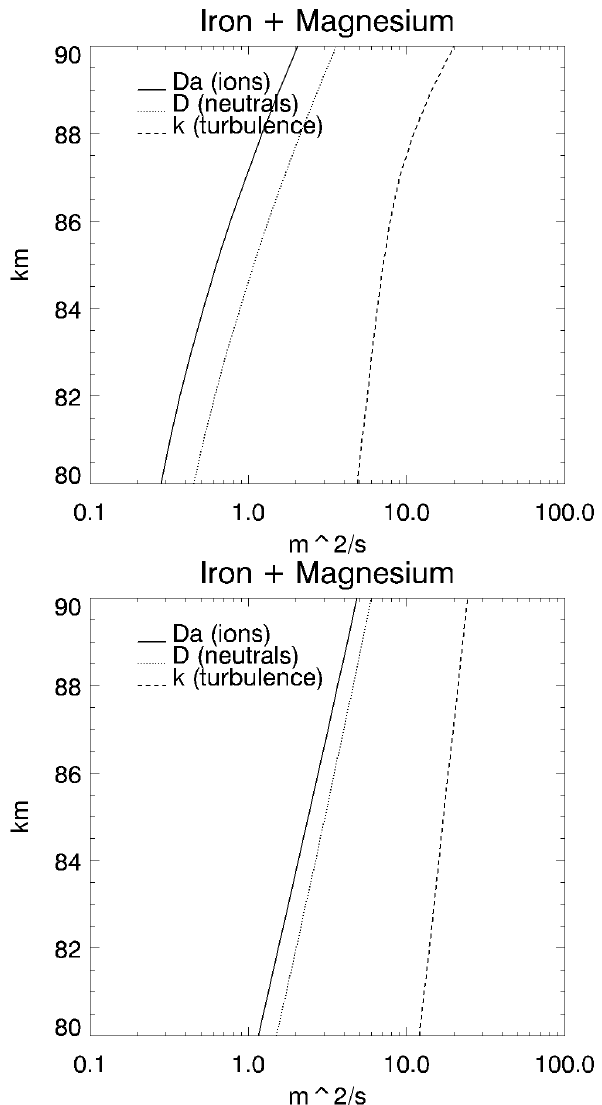
Fig. 1. Diffusion coefficient profiles. Solid lines: ambipolar dif- fusion assuming a mixture of Fe + and Mg + ; Dotted lines: neutral atmosphere; Dashed line: turbulence (see text). Upper panel: sum- mer; lower panel: winter.